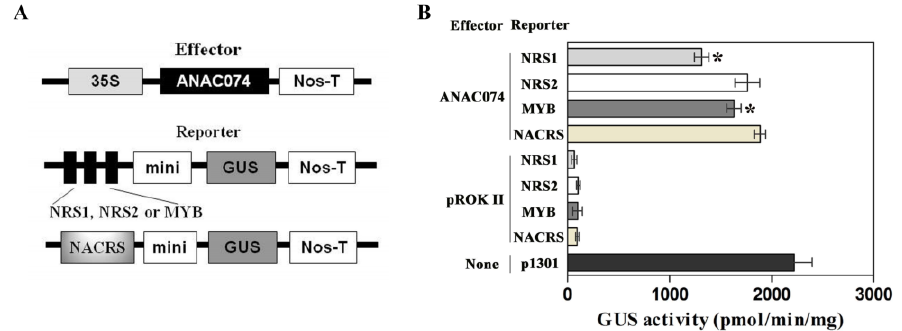
Figure 5. Comparison of the binding affinities of NACRS, NRS1, NRS2, and MybSt1 to ANAC074. ( A ) Schematic diagram of the reporter and effector constructs. ( B ) Three tandem copies of NRS1, NRS2, MybSt1, or one copy of NACRS were respectively fused with minimal promoter to drive GUS , and co-transformed with ANAC074 under control of 35S promoter into tobacco leaves. GUS activity was determined to study their binding affinity. The empty pCAMBIA1301 was used as positive control. Co-transformed empty pROKII with pCAM-NRS1, pCAM-NRS2, pCAM-MYB, or pCAM-NACRS were as negative controls. Data represent mean values of three independent experiments, and bars indicate standard deviation (SD). Asterisks indicate a significant difference compared with NACRS (Student’s test; * p < 0.05).